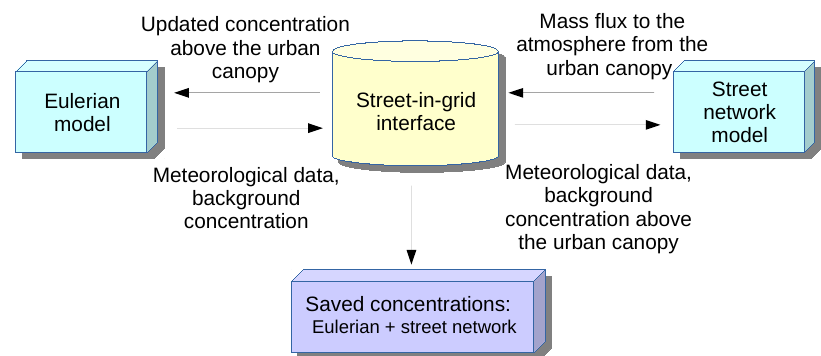
Figure 3. Schematic diagram of the Street-in-Grid model.